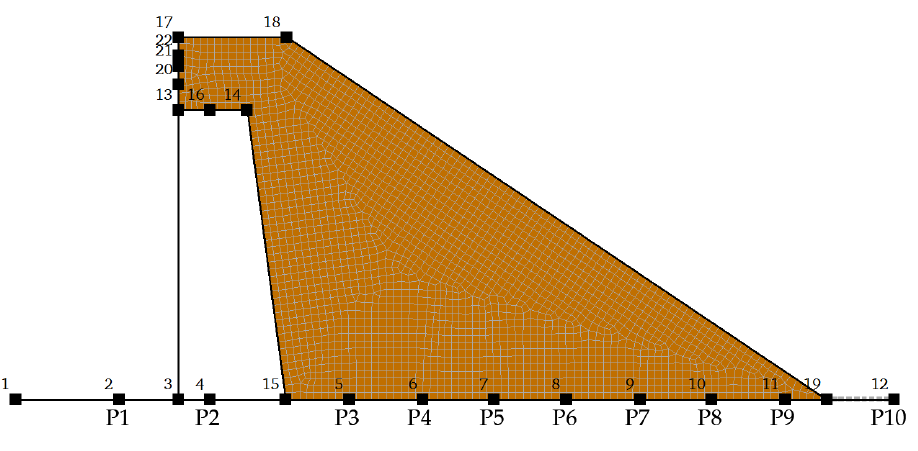
Figure 7. Design of the numerical model, showing the mesh and numbered